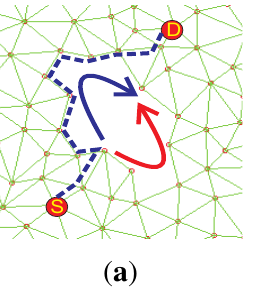
Figure 2. Comparison of face routing in 2D and 3D networks. Node S has a shorter distance to destination, D , than all of its neighbors and, thus, is a local minimum. ( a ) Face routing is successful in a 2D planar network, because a concave void is a face with a simple line boundary and, thus, a local deterministic algorithm can be employed to search the boundary in either the clockwise or counter-clockwise direction, as shown by the blue and red lines. ( b ) In a 3D network, a void is no longer a face. Its boundary becomes a surface, yielding an arbitrarily large number of possible paths to be explored (as indicated by the arrows). Thus, face routing fails.